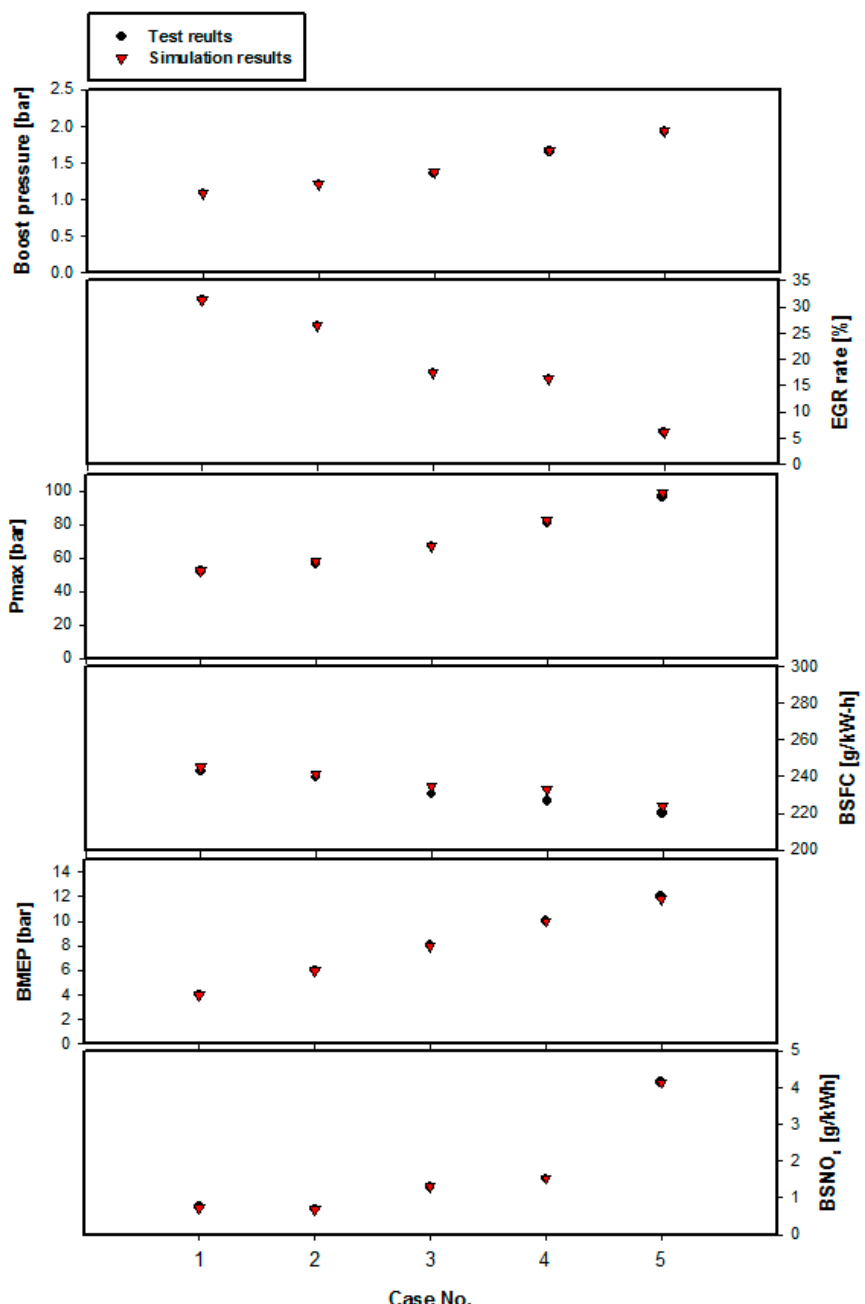
Figure 7. Comparison between experimental and numerical results: boost pressure, EGR rate, maximum cylinder pressure, brake-specific fuel consumption (BSFC), BMEP, and brake-specific NO x (BSNO x ).